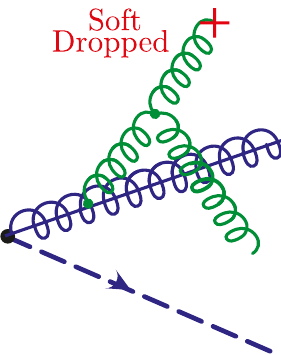
Figure 8. Schematic illustration of a con(cid:12)guration of emissions that contributes to collinear non- global logarithms. The soft-collinear gluon emission o(cid:11) of the hard-collinear gluon is groomed away, but not before it re-emitted into the ungroomed region between the two hard